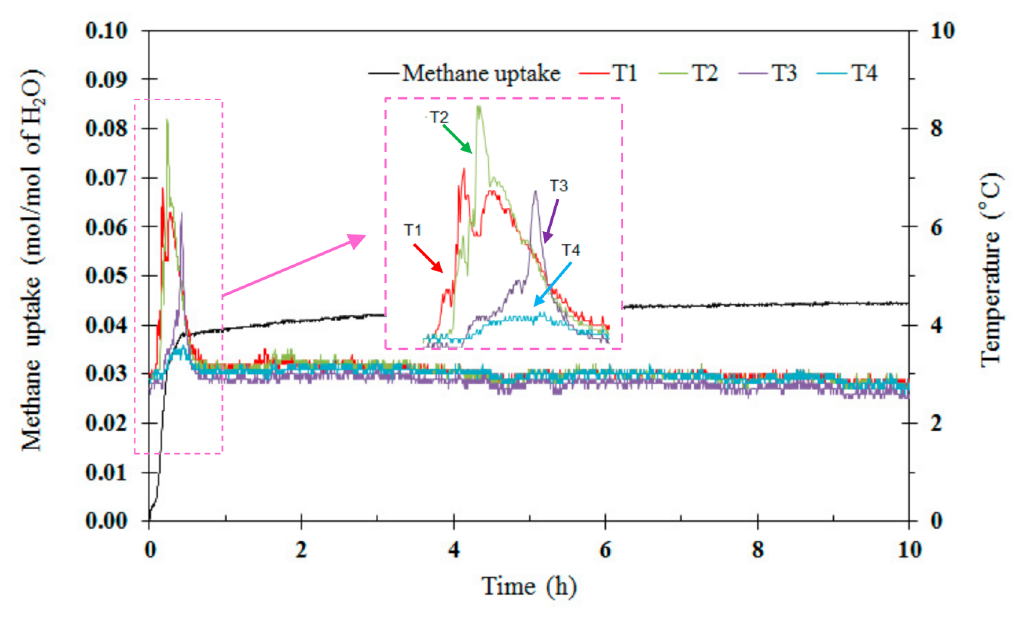
Figure 7. Methane uptake and temperature profiles during the methane hydrate formation experiments performed with 10% v / v at 2.5 ◦ C (Experiment 16, Table